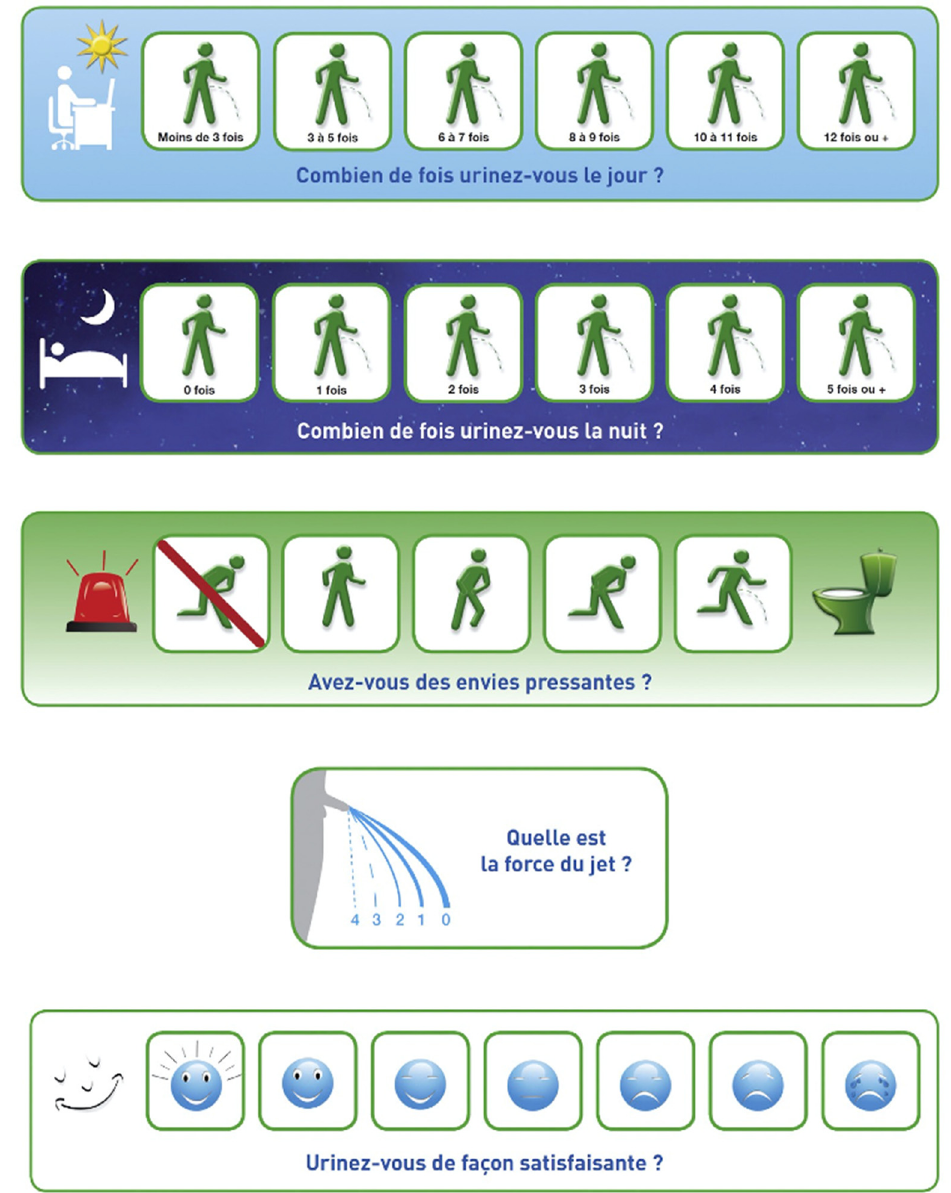
Figure 3. Score Visuel Prostatique en Image (SVPI) [21]. English translations: “Less than 3 times”; “3 to 5 times”; “6 to 7 times”; “8 to 9 times”; “10 to 11 times”; “12 times or +”. “How often do you urinate during the day?”. “0 times”; “1 time”; “2 times”, “3 times”; “4 times”; “5 times or +”.